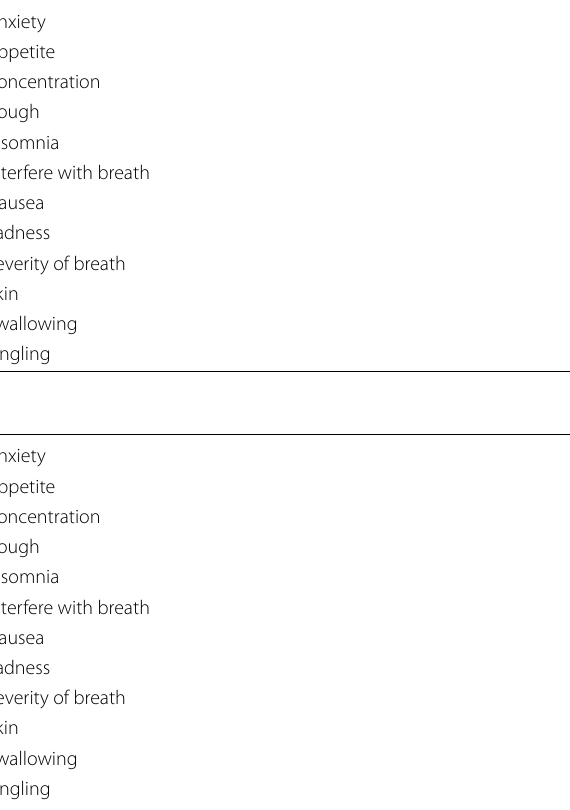
PRO-CTCAE, Patient-Reported Outcomes version of the Common Terminology Criteria for Adverse Events